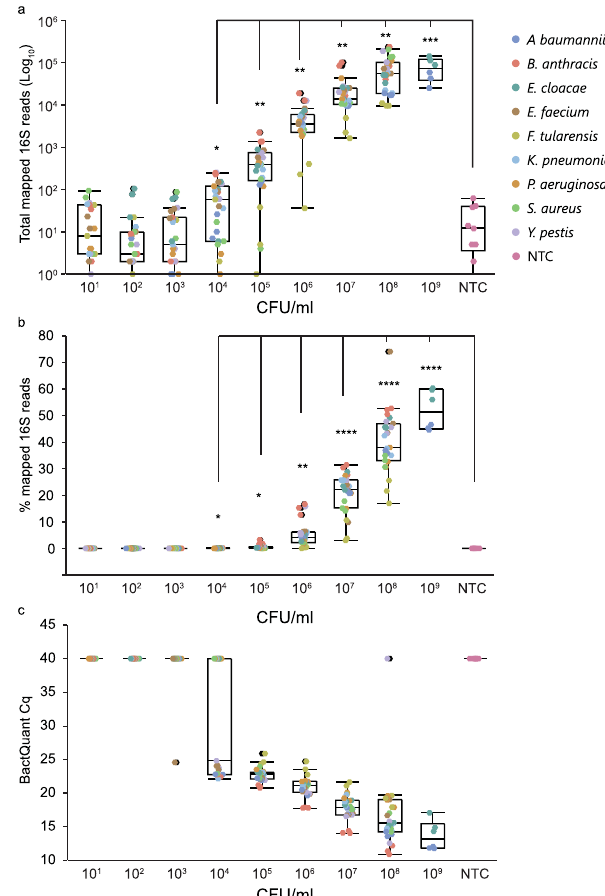
Figure 2. Detection of 16S gene sequence from blood culture matrix utilizing two molecular techniques. Pooled 16S MIPs were tested against DNA extracts prepared from serial-dilutions of blood culture matrix spiked with biothreat and ESKAPE pathogens at concentrations ranging from 10 9 –10 1 CFUs/ml. Sequencing reads were processed and mapped against three reference databases containing 16S variable regions V1/2, V3, and V6/V7. ( a ) Total mapped sequencing reads ( b ) percentage of mapped sequencing reads and ( c ) C q s resulting from real-time PCR with the BactQuant assay is plotted versus CFU/ml. Three independently extracted replicates for each organism are represented. Data points were combined and a corresponding outlier box plot was generated for each variable. Prepared blood culture without pathogen was used as a negative control. Unpaired parametric t-tests were used for statistical evaluation. P values < 0.05, 0.01, 0.001, and 0.0001 are indicated with asterisks * , ** , *** , and **** respectively.